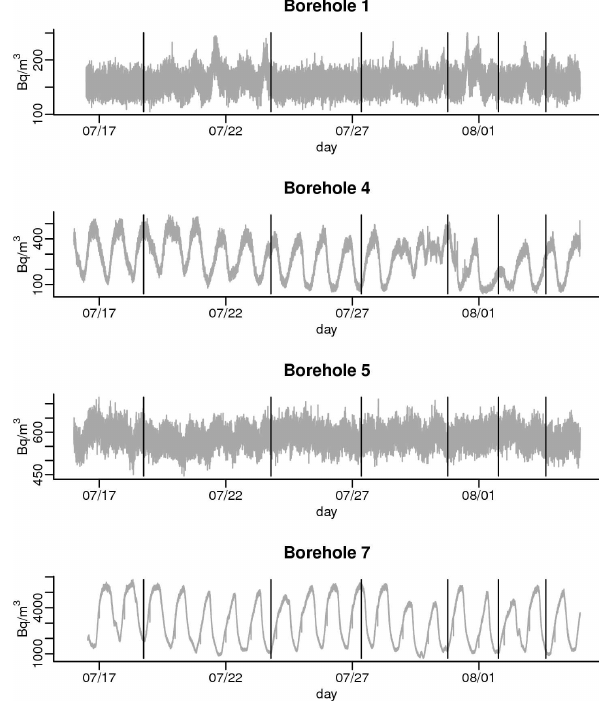
Fig. 3. Time series (1-min rate) of radon concentration for the pe- riod from 16 July to 4 August. The vertical solid lines indicate the time of explosions in the quarry.